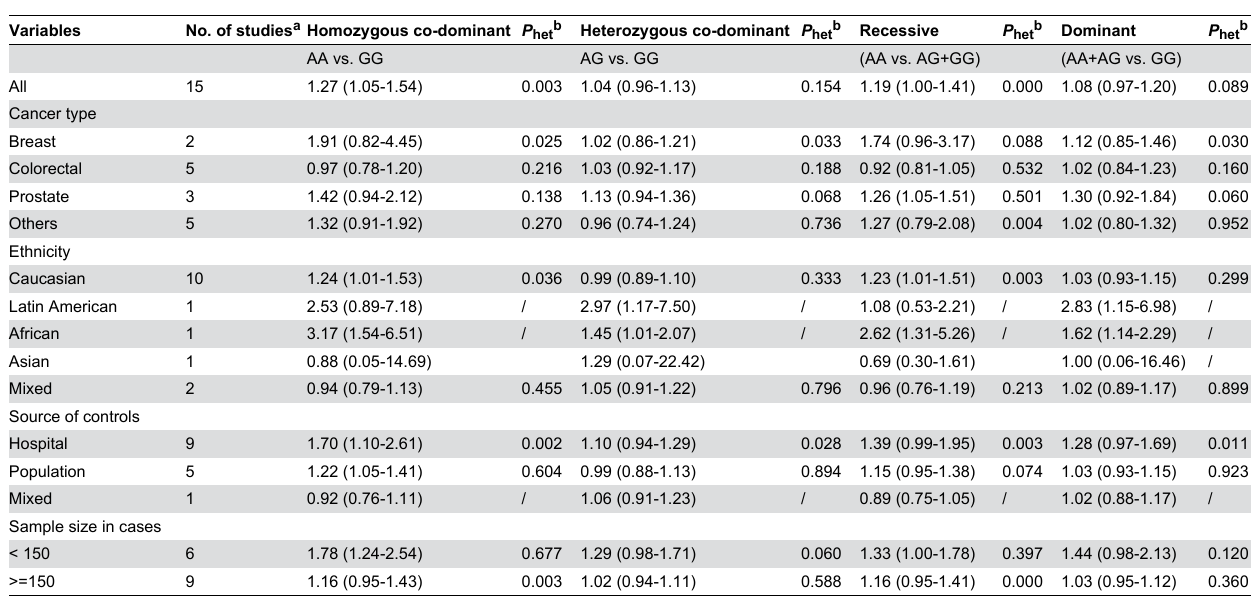
Table 2. Meta-analysis of the association between LEP G2548A polymorphism and cancer risk.